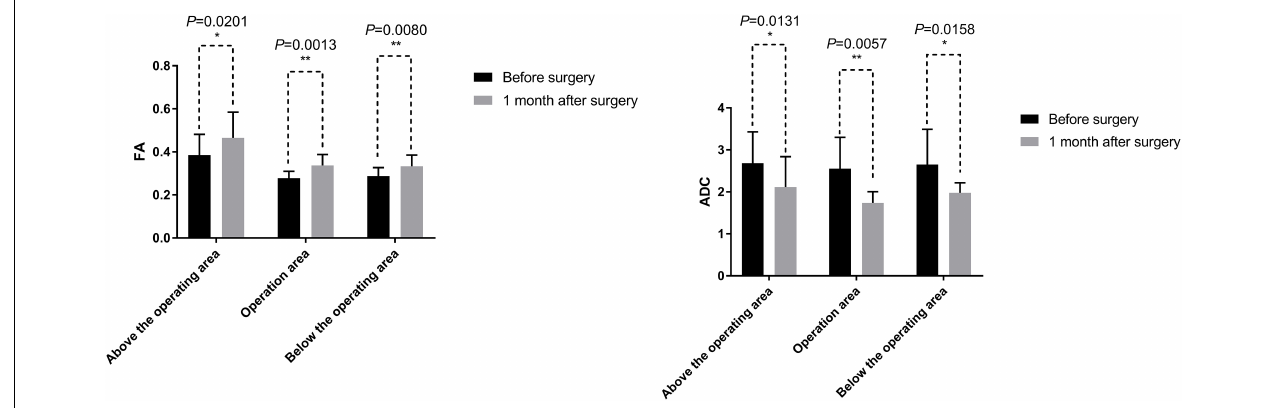
FIGURE 9 | DTI related measurements include fractional anisotropy (FA) and apparent diffusion coefficient (ADC). The mean values of FA at 1 month after the surgery were greater than before the surgery. The difference of FA values before and 1 month after the surgery was statistically significant by a paired sample t -test ( p < 0.05). The mean values of ADC at 1 month after the surgery were less than that before the surgery. The difference of ADC values before and 1 month after the surgery was statistically significant by a paired sample t- test ( p < 0.05). *, 0.01 < p < 0.05; **, p <